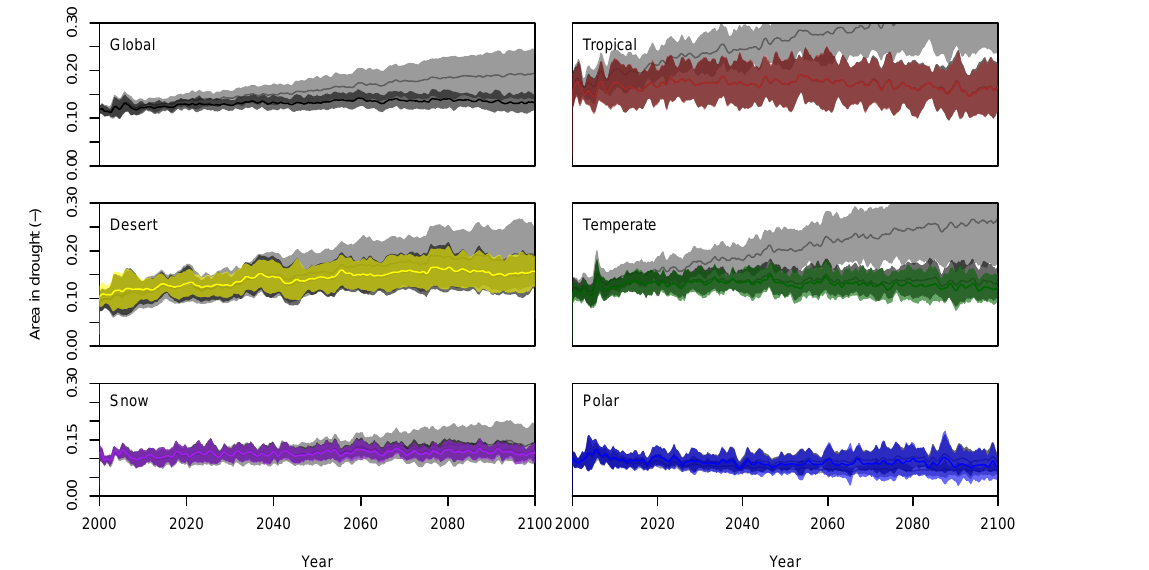
Figure 5. Projected evolution of ensemble mean area (solid line) and the spread in hydrological drought in the 21st century derived from simulation with PCR-GLOBWB, forced by an ensemble of 20 scenarios consisting of four RCPs and five GCMs. The evolution is given for the globe and for the five major Köppen–Geiger climatic regions. The coloured lines present the evolution under a changing hydrological regime with changing climate types per cell (transient variable threshold, VTM t ), dark grey without a changing climate per cell with the VTM t and light grey the evolution under a stationary hydrological regime (non-transient variable threshold,